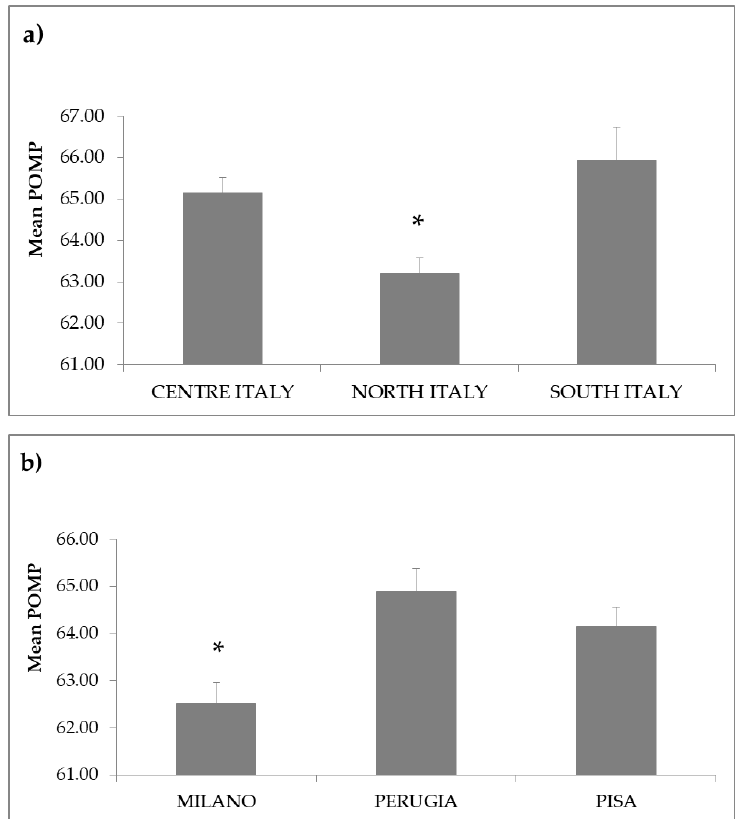
Figure 2. (a) Mean ± SE POMP score of AAS by students’ provenance; ( b ) Mean ± SE POMP score by students’ university. Data were analyzed using a Kruskal–Wallis test with Bonferroni’s correction ( p = 0.001) (* = significant difference vs the other two groups). POMP: Percentage of maximum possible score; AAS: Animal Attitude Scale.